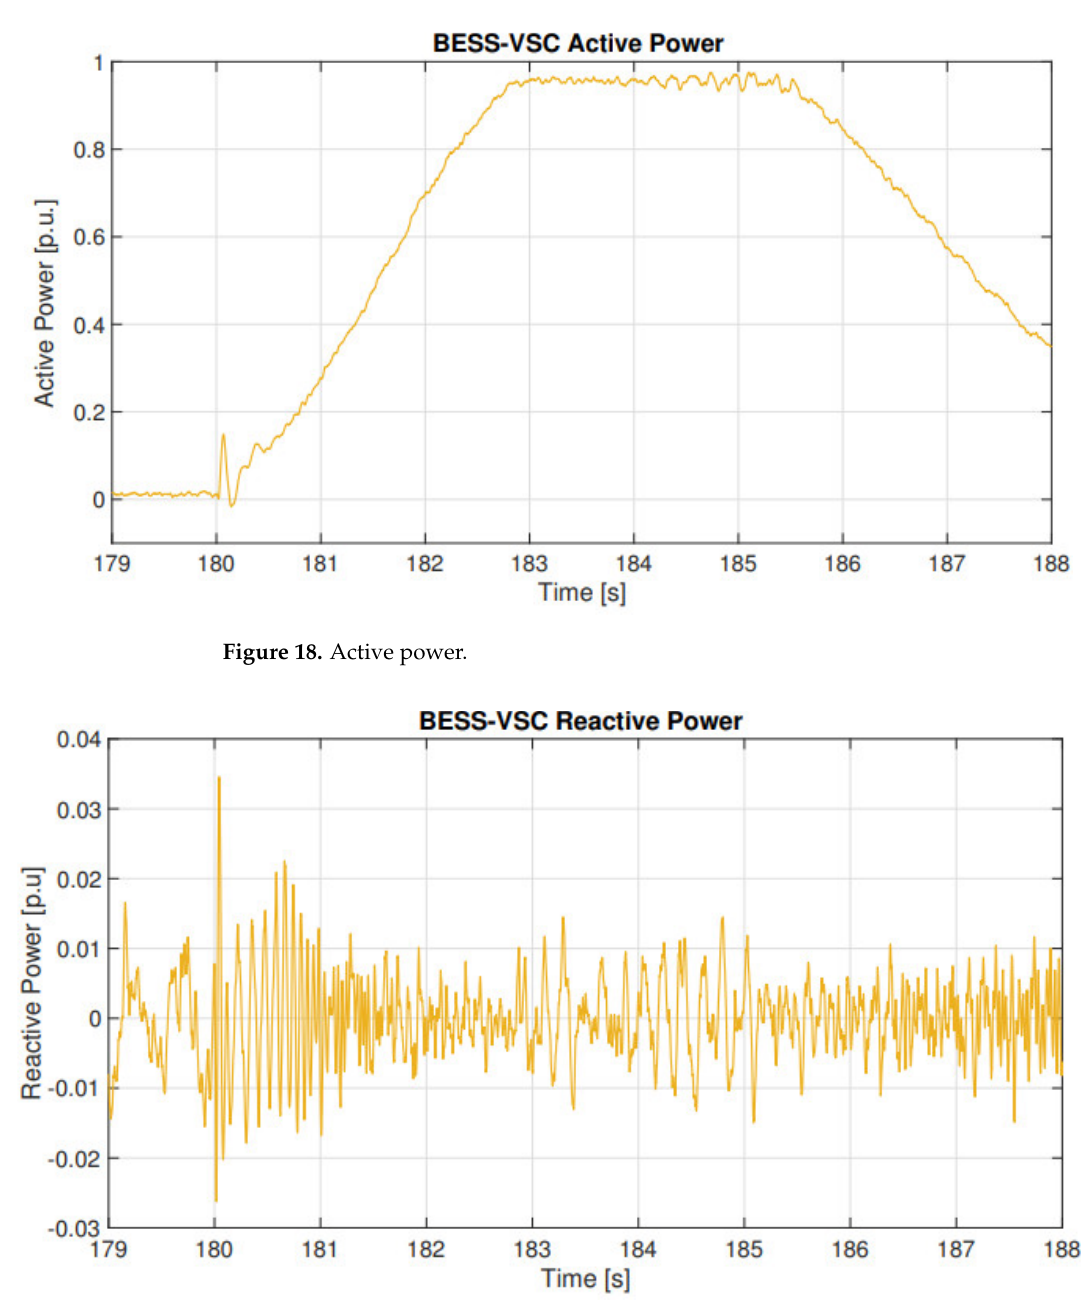
Figure 19. Reactive power.